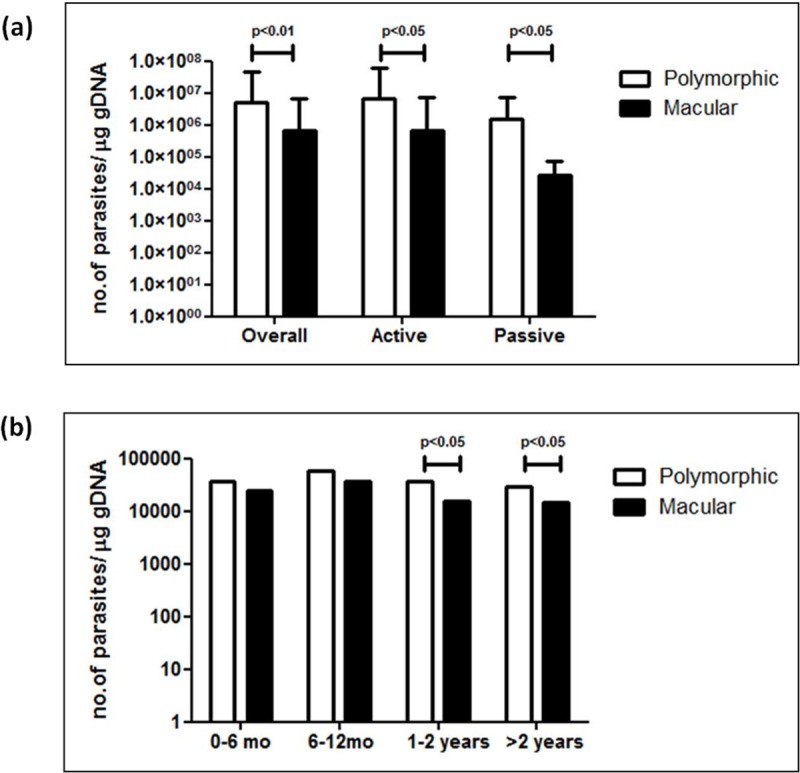
Effect of surveillance and disease duration on parasite load.(a) Bar diagram showing parasite burden in polymorphic and macular PKDL following passive and active surveillance [Values given in Mean ± SEM] (b) Bar diagram showing median parasite burden in polymorphic vs. macular PKDL with disease progression.